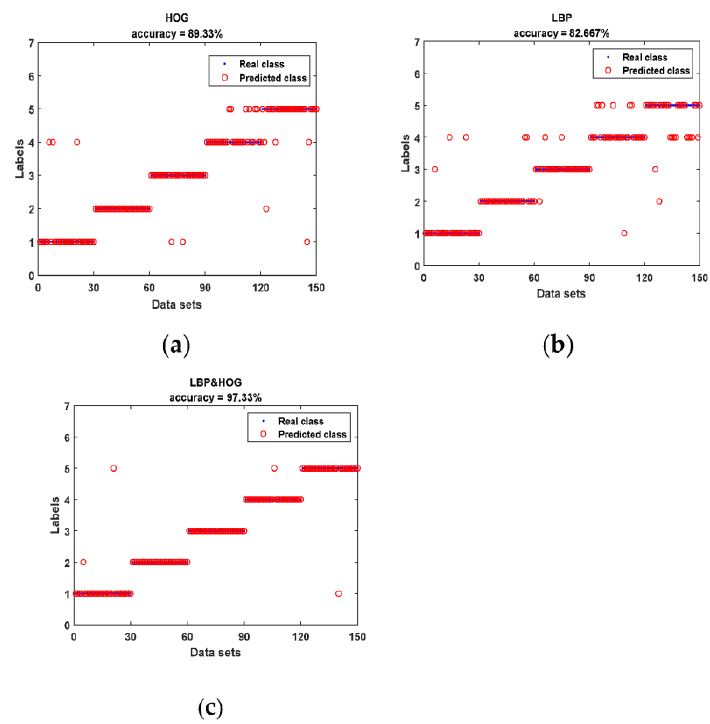
Figure 9. The damage identification results: ( a ) LBP, ( b ) HOG and ( c ) LBP&HOG. The quality of the output of the PSO-SVM classifier was evaluated by the perfor- mance parameters [45] precision, recall, F1-score and error rate in the classification task, as shown in Table 5. Table 5. The common evaluation metrics results of PSO-SVM. Precision